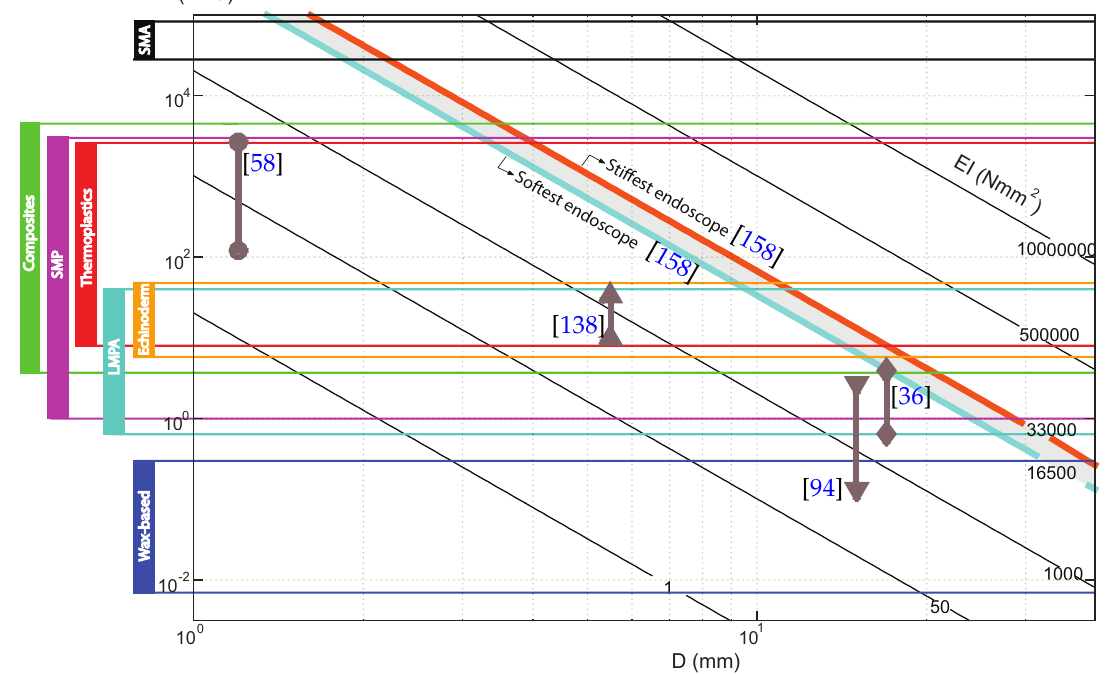
Figure 8. Elastic modulus ( E ) of material-based solutions compared to an equivalent external diameter ( D ) and flexural stiffness ( EI ) (diagonal lines). The objectives of bending stiffness defined by the stiffest and softest endoscopes on the market are the highlighted diagonal lines. Some examples from the literature are represented to illustrate the range of diameters and elastic moduli that have been tested. This graph gives an indication about the material to choose for achieving a given bending stiffness ( EI ) when an external diameter ( D ) is imposed, and